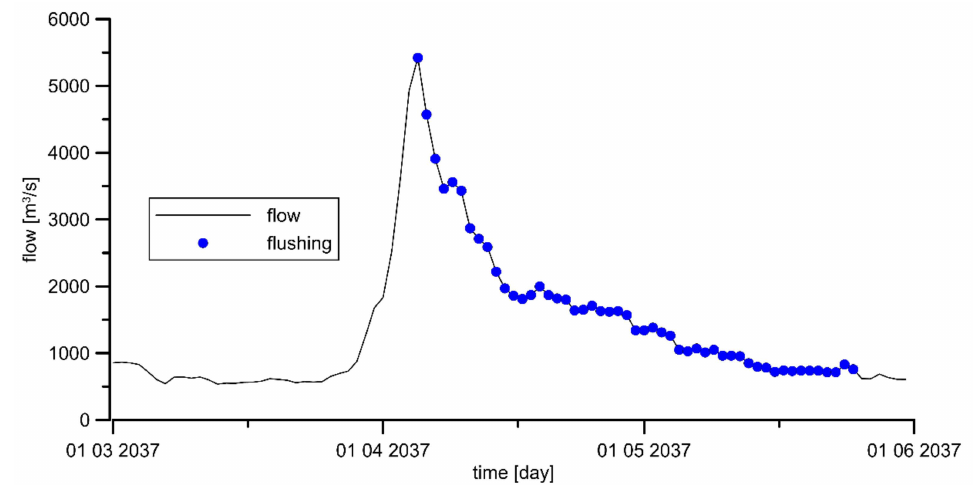
Figure 8. The first flooding used for the flushing process through the Gniew Barrage; solid line—flow through the barrage, points—days on which flushing is carried